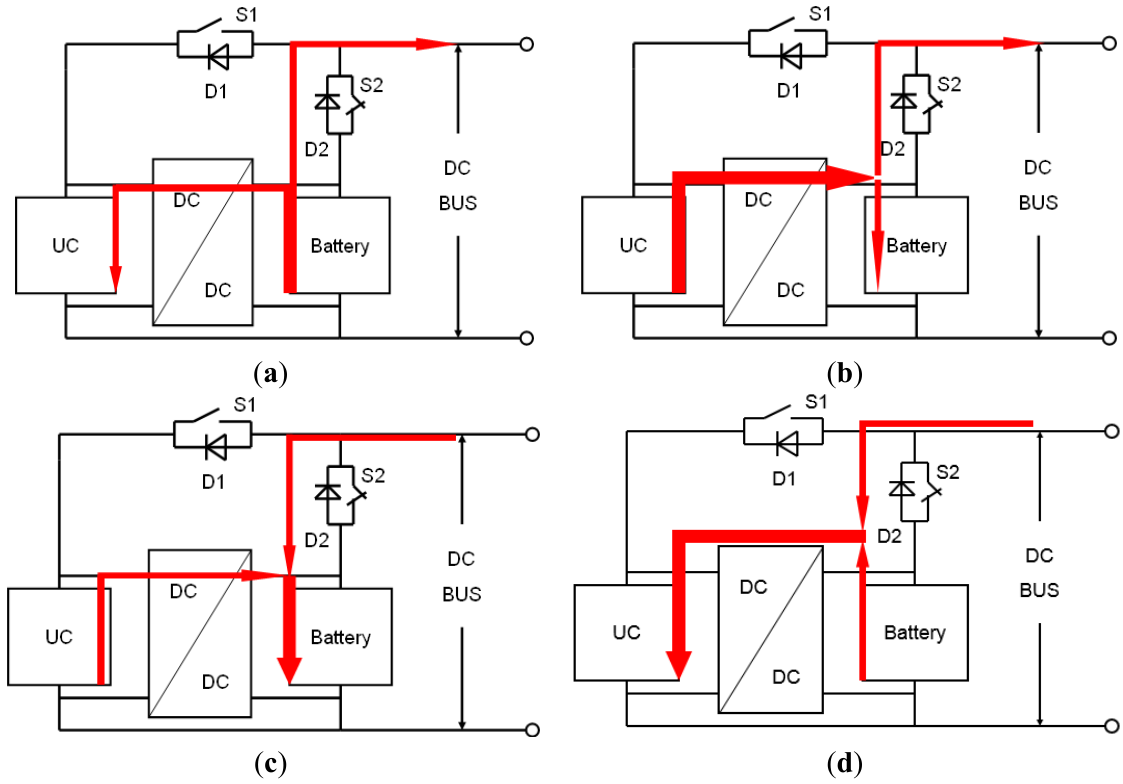
Figure 5. Energy flows in Mode II for the low power